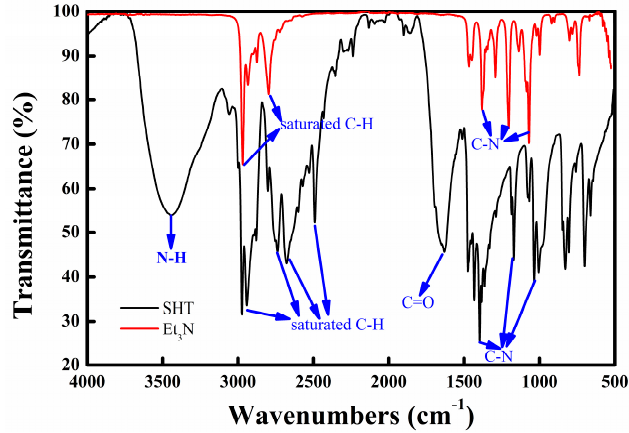
Figure 3. The Fourier transform–infrared (FT–IR) spectra of Et 3 N and SHT.